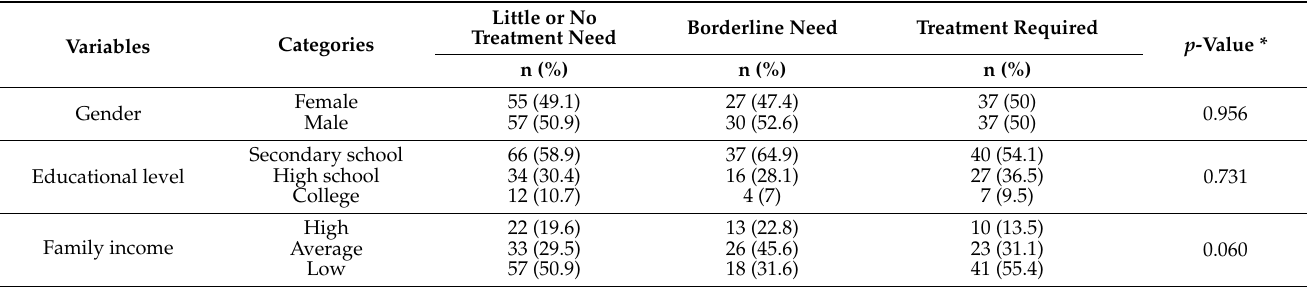
Table 1. IOTN-DHC by demographic characteristics of the study participants (N = 243).